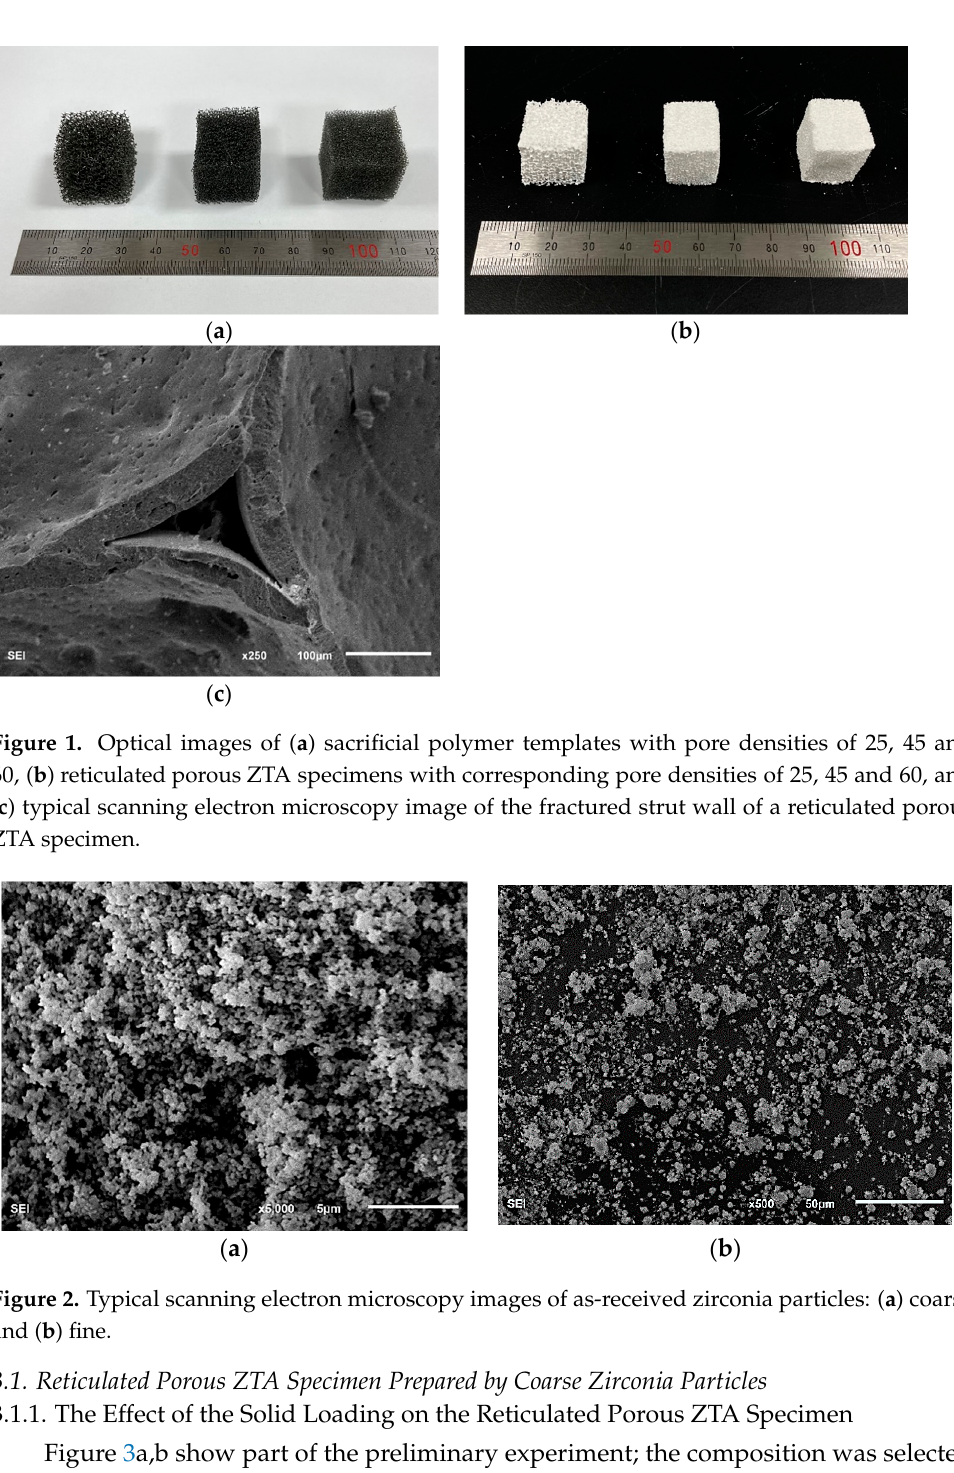
Figure 2. Typical scanning electron microscopy images of as-received zirconia particles: ( a ) coarse and ( b ) fine.